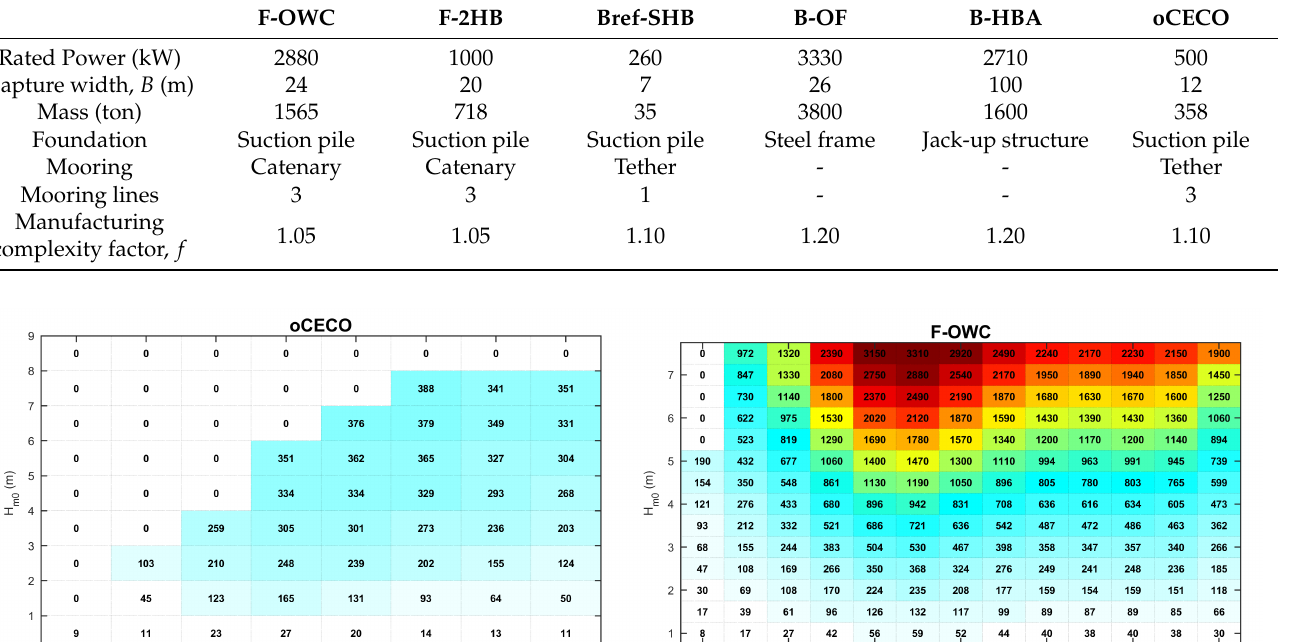
Table 2. Main characteristics of case-study WECs.